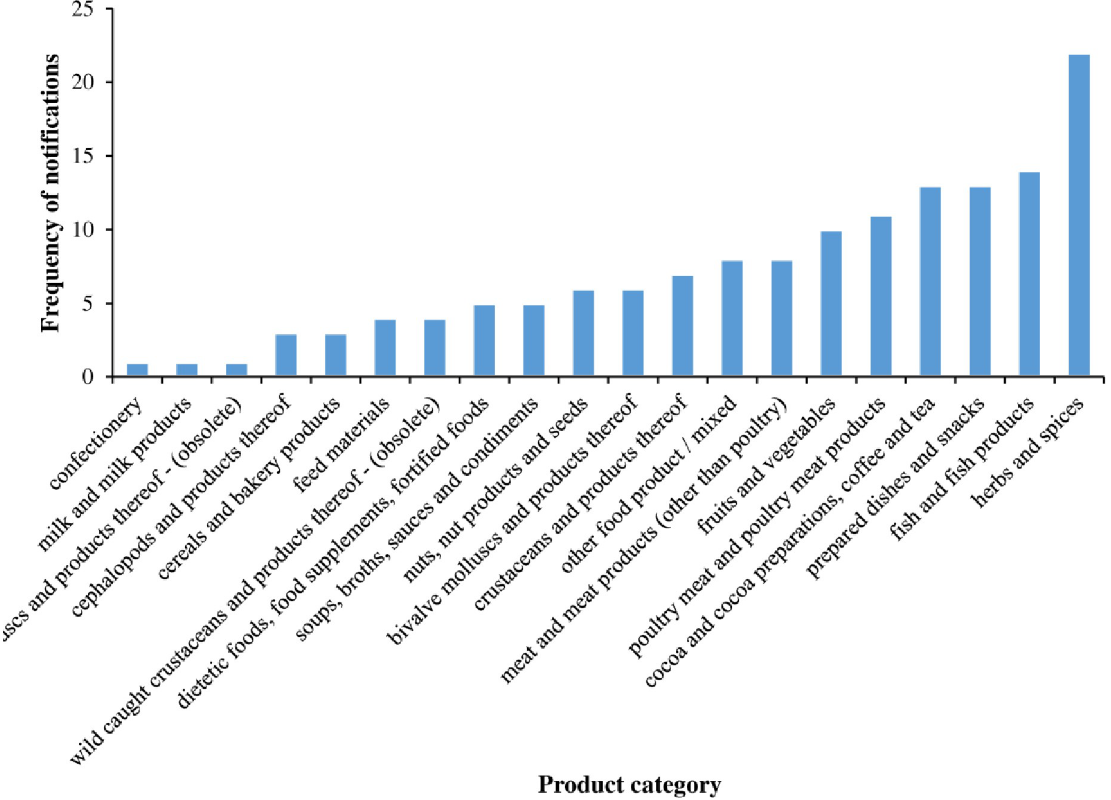
Fig 2. Frequency of food fraud notifications in RASFF by food/feed product category the year (2000–2020).